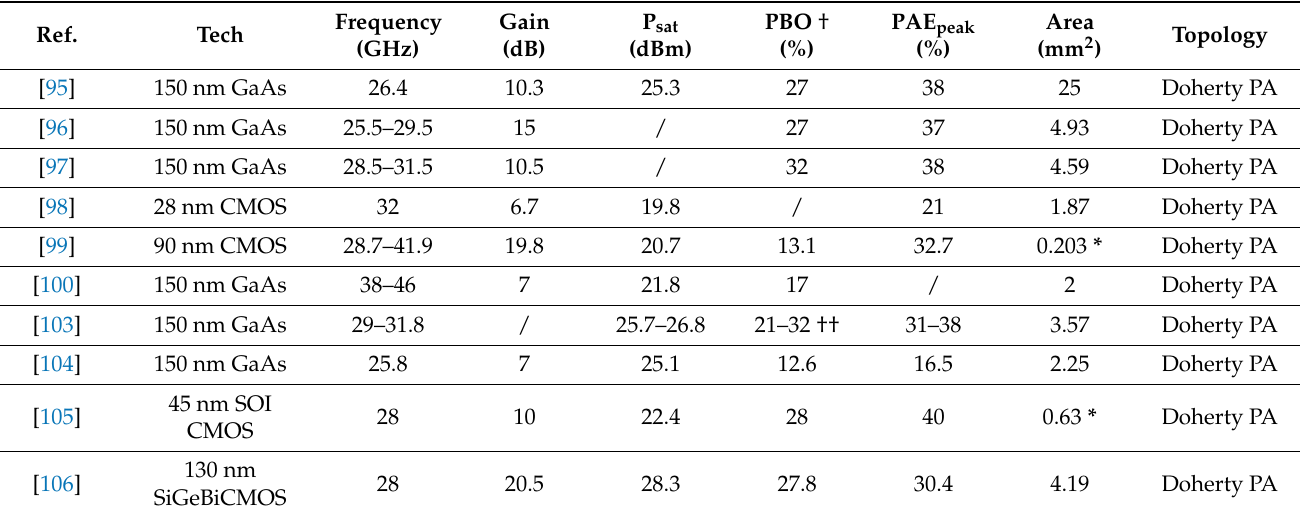
Table 5. Comparison of the measurement results with the Doherty PA in